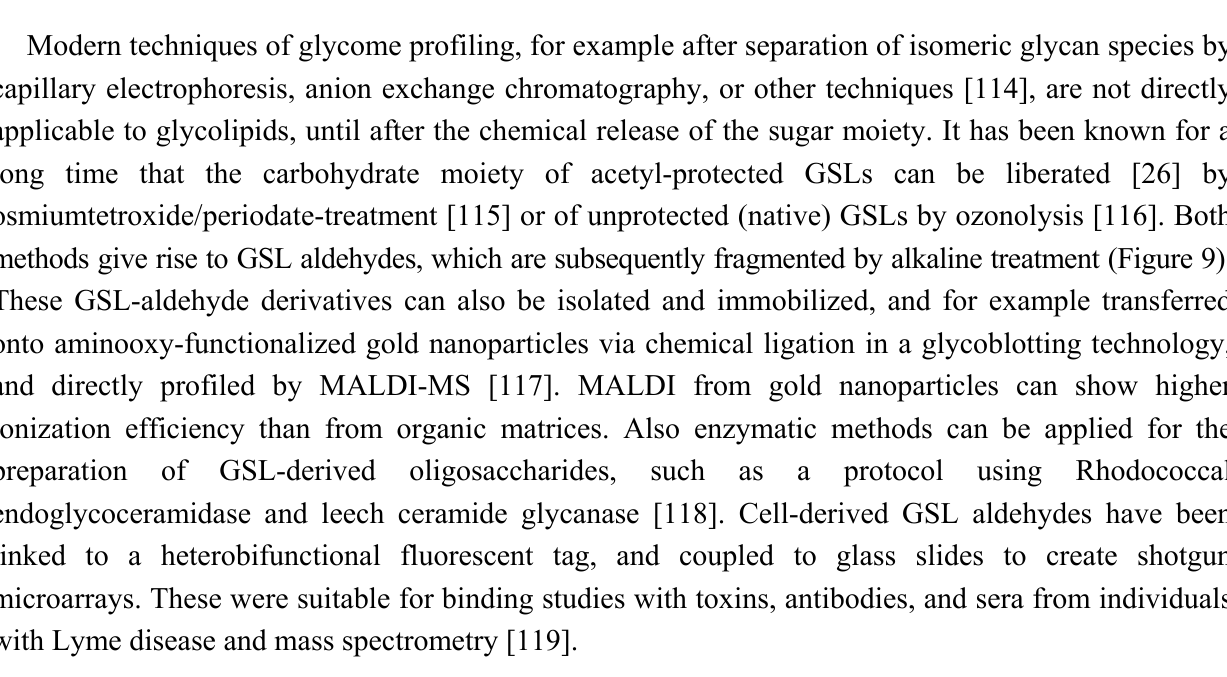
Figure 9. Oxidative cleavage of GSL and fragmentation of the resulting GSL-aldehydes. This gives access to GSL